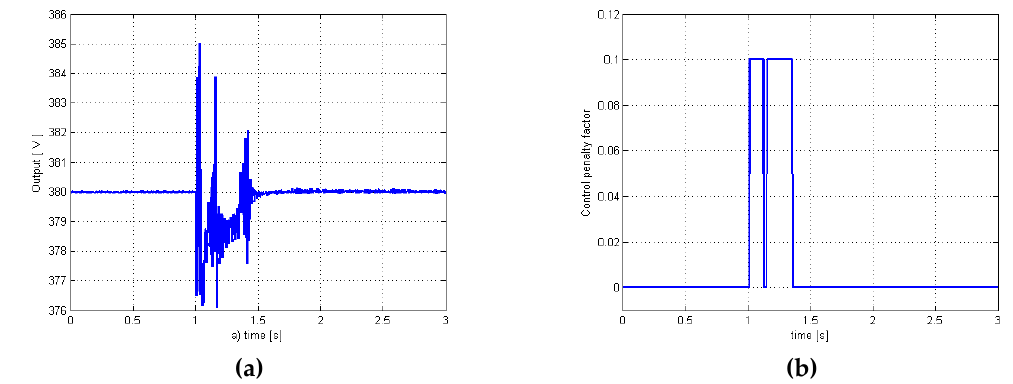
Figure 5. ( a ) Controlled output (terminal voltage)—constant ρ ∈ { 0.0001, 0.1 } ( ∆ T m = 24%); ( b ) Variable Figure 5. (a) Controlled output (terminal voltage)—constant (cid:2025) ∈ {0.0001, 0.1} ( (cid:1986)(cid:1846) (cid:3040) = 24% ); (b) setting of control penalty factor. Variable setting of control penalty factor